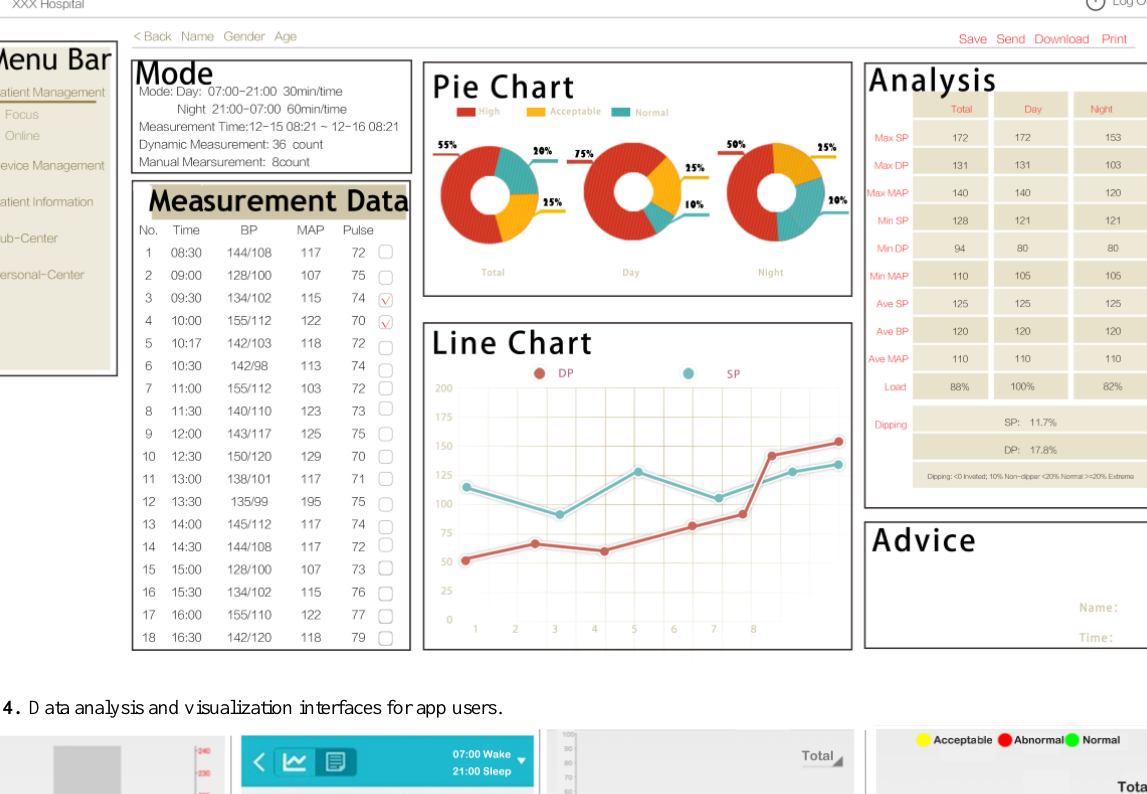
Figure 3. The Web user interface of the Health Data Center.